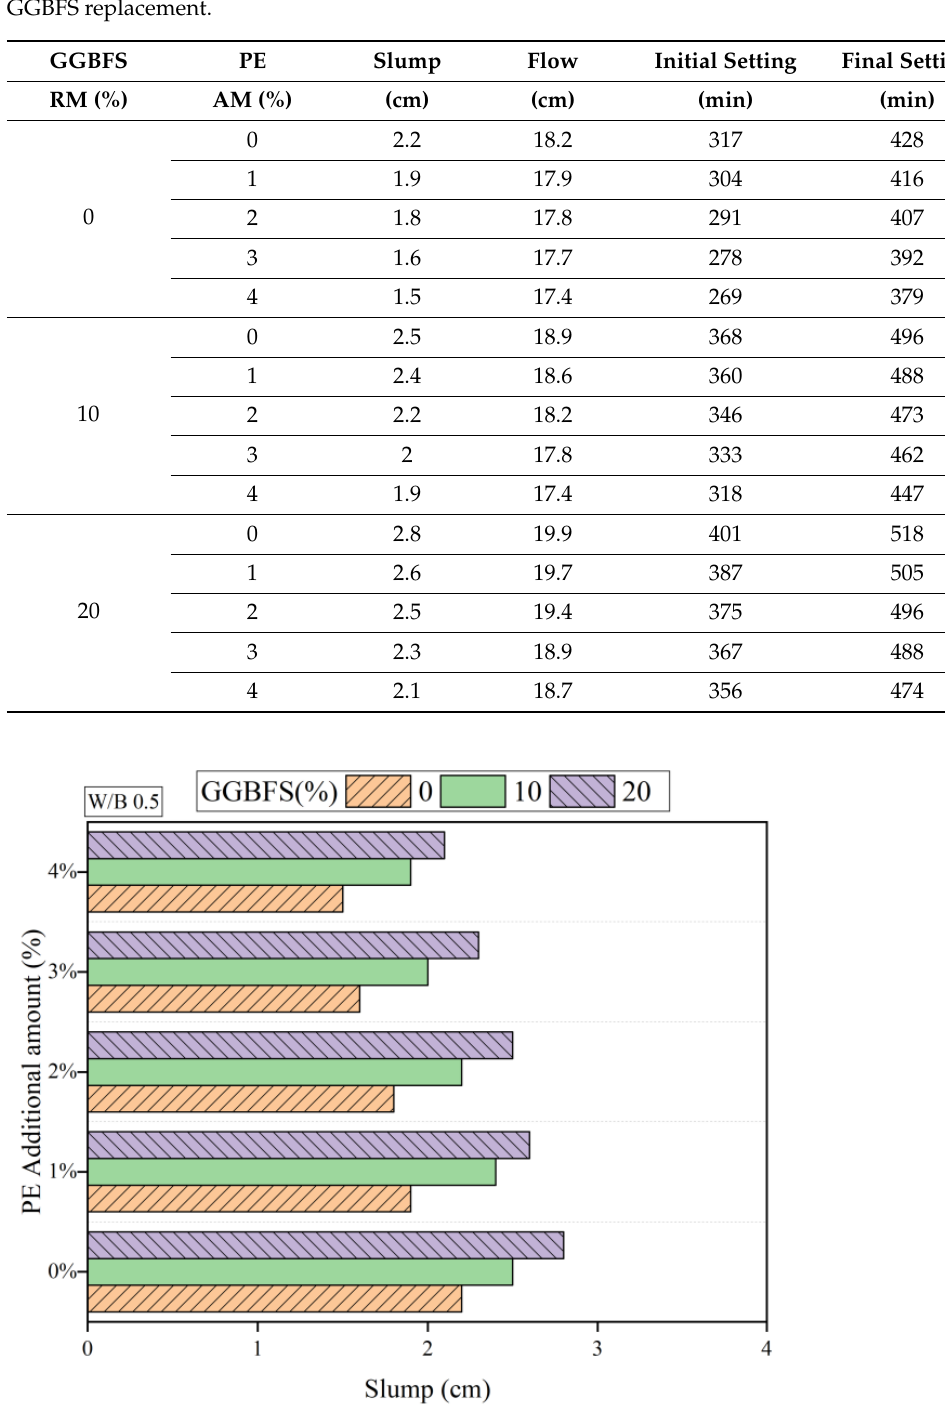
Figure 3. The slump of cement mortars with the addition of different ratios of waste PE and GGBFS replacement. Table 4. Fresh properties of cement mortar with the addition of different ratios of waste PE and GGBFS replacement.